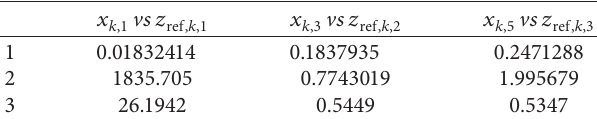
Figure 14: Rotors frequencies for random tracking. Table 1: MSEs for Examples